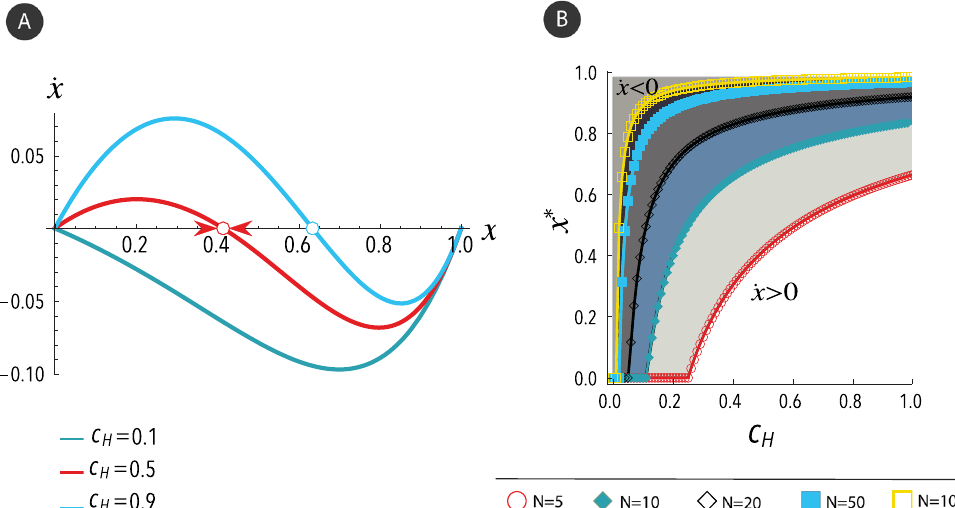
Figure 1. Gradient of selection and equilibria of the N-person Hawk-Dove Game in infinite populations. ( a ) Gradient of selection  x in the N-person HDG as a function of the frequency x of doves, for a sample size of N = 5. Different colors stand for different costs c H = 0.1, 0.5, 0.9. Circles represent the interior attractors indicating the coexistence of hawks and doves in the steady state. ( b ) Equilibria of the N-person Hawk-Dove Game in infinite populations for different values of cost c H . x * represents the equilibrium fraction of doves in the population. There is a critical value c cv = 1/( N − 1) for the cost c H beyond which hawks and doves coexist. The resource is taken as unity R = 1. See the main text for further